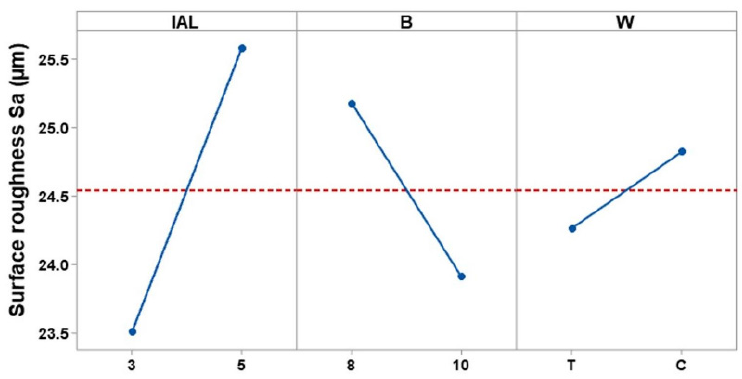
Figure 13. Main effects plot for average surface roughness. Table 6. ANOVA for average surface roughness.